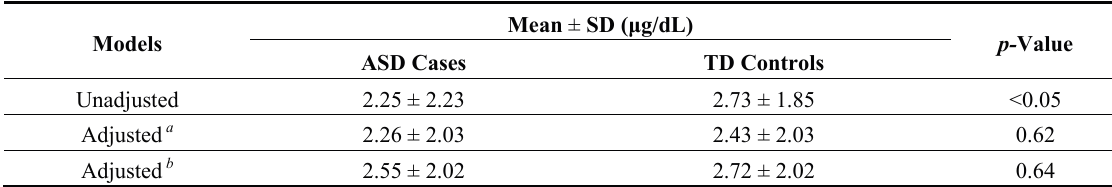
Table 4. Unadjusted and adjusted mean blood lead concentrations for 100 ASD cases and their 1:1 matched controls based on the